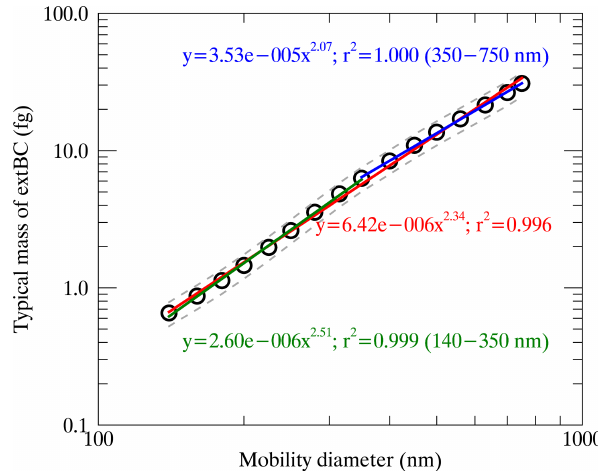
Figure 3. The mass of extBC particles as a function of the mobil- ity diameter in the range of 140–750nm (black circles), fitted by a power-law relationship (red line). The power-law functions piece- wise fitted in the 140–350nm mobility range (green line) and in the 350–750nm mobility range (blue line) are overlaid. The dashed lines represent the uncertainties in the determined extBC